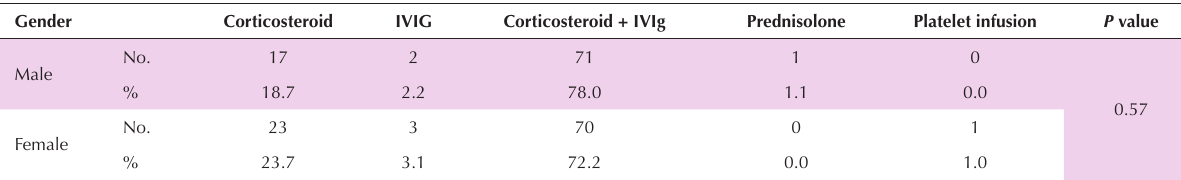
Table 5. Comparison of different therapies based on gender